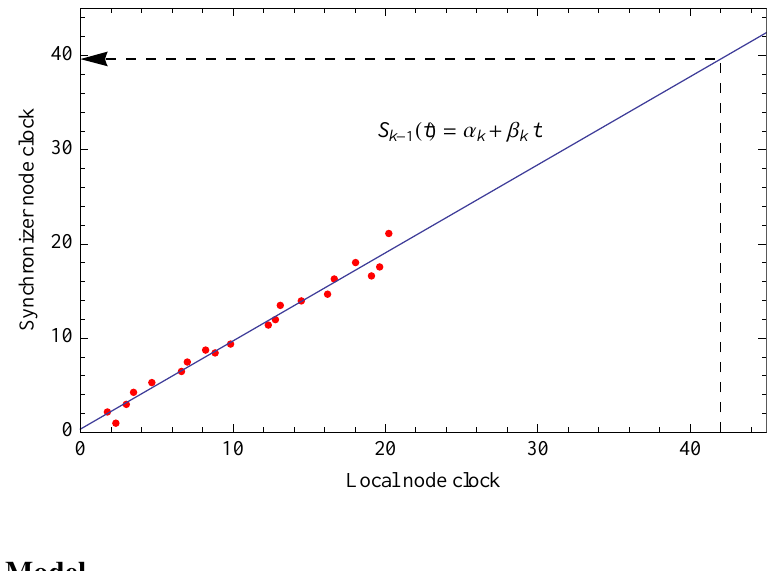
Figure 4. Regression line performed in a level k node, with several broadcast time stamps from a level k − 1